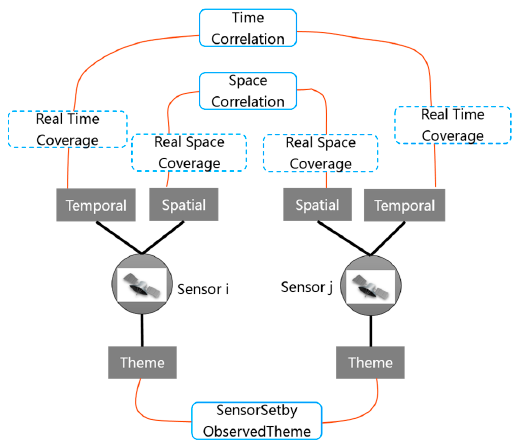
Figure 12. Sample of dynamic observation capability association among multi-sensors.